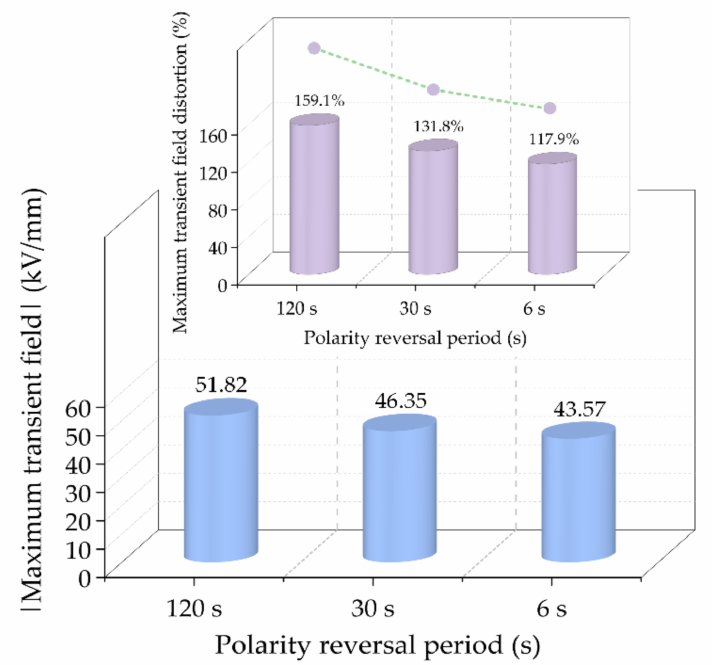
Figure 9. Absolute values of maximum transient fields and the corresponding field distortion, under a PRP of 120 s, 30 s and 6